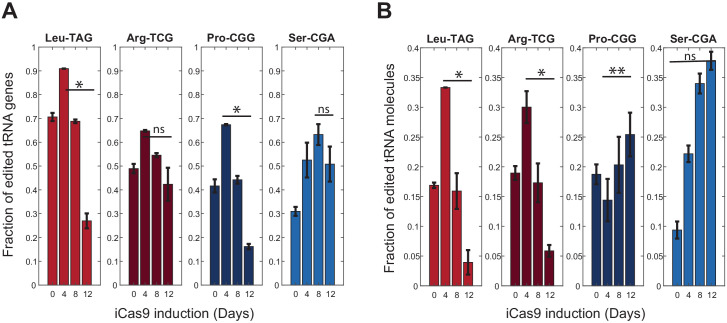
Fraction of edited tRNAs in CRISPR-targeted HeLa cells from genomic and mature tRNA sequencing.(A) Bar plots describing the changes in the fraction of edited tRNA reads from genomic tRNA sequencing (B) Bar plots describing the changes in the fraction of edited tRNA reads from mature tRNA sequencing. Each bar represents a time point during the iCas9 induction (n = 2), error bars depicts standard errors. The two left plots describe the proliferation CRISPR-targeted tRNA samples and the two left plots describe the differentiation CRISPR-targeted tRNA samples. ** indicates p<0.01, * indicates p<0.05 and ns indicates non-significant p-value of two-sample T-tests comparing between the sample with the highest fraction of edited tRNA reads and the last time point.